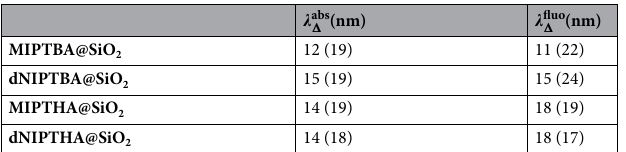
abs (cid:31) ) and fluorescence (